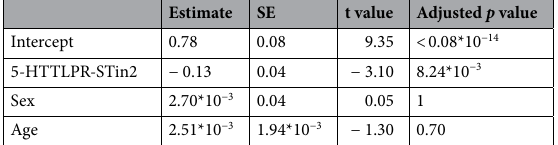
Table 9. General linear model for risk of SCZ using 5-HTTLPR-STin2